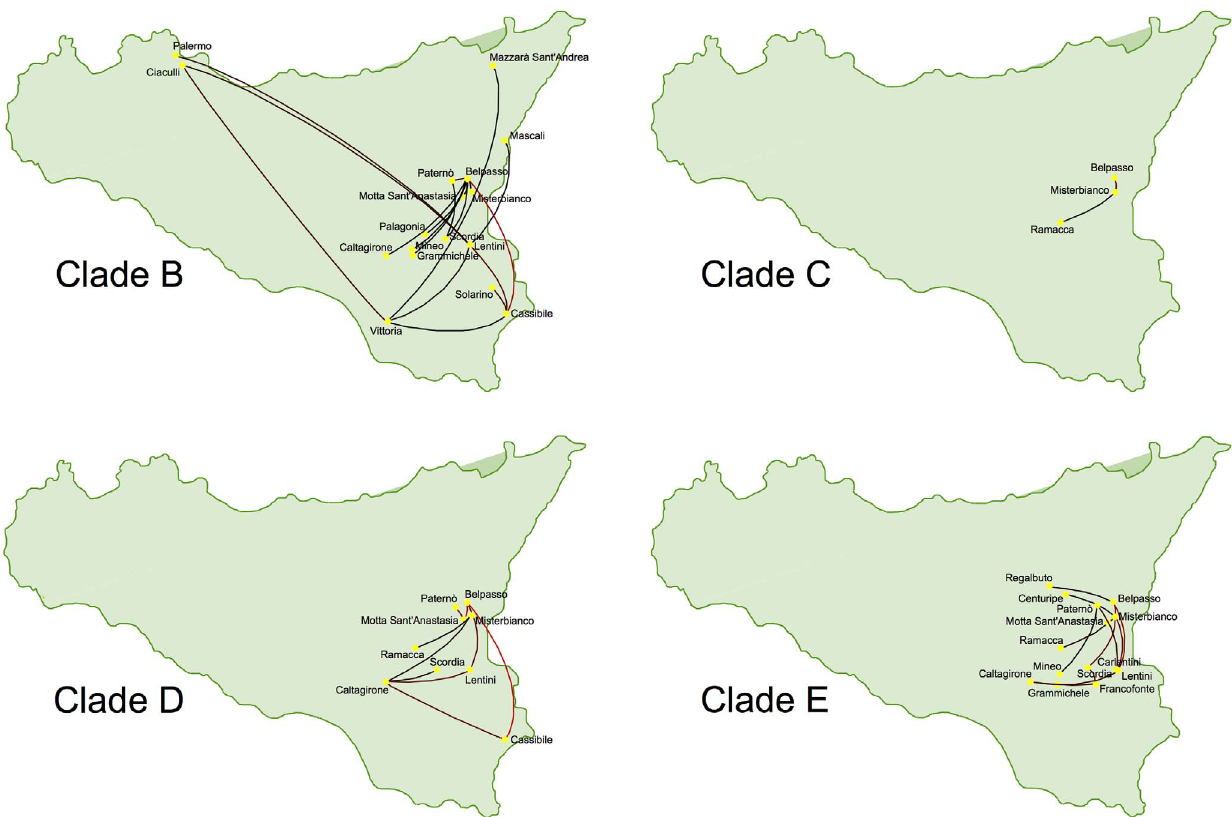
Figure 4. Inferred migration graph for the different introductions of CTV in Sicily associated to clades B, C, D and E reconstructed from the MCC tree. The branches are colored according to the node height values to the colors between the specified maximal (red) and minimal boundary (black). Only introductions associated to clades B, C, D and E are shown since clade A has only a single Sicilian isolate. doi:10.1371/journal.pone.0066700.g004 PLOS ONE |